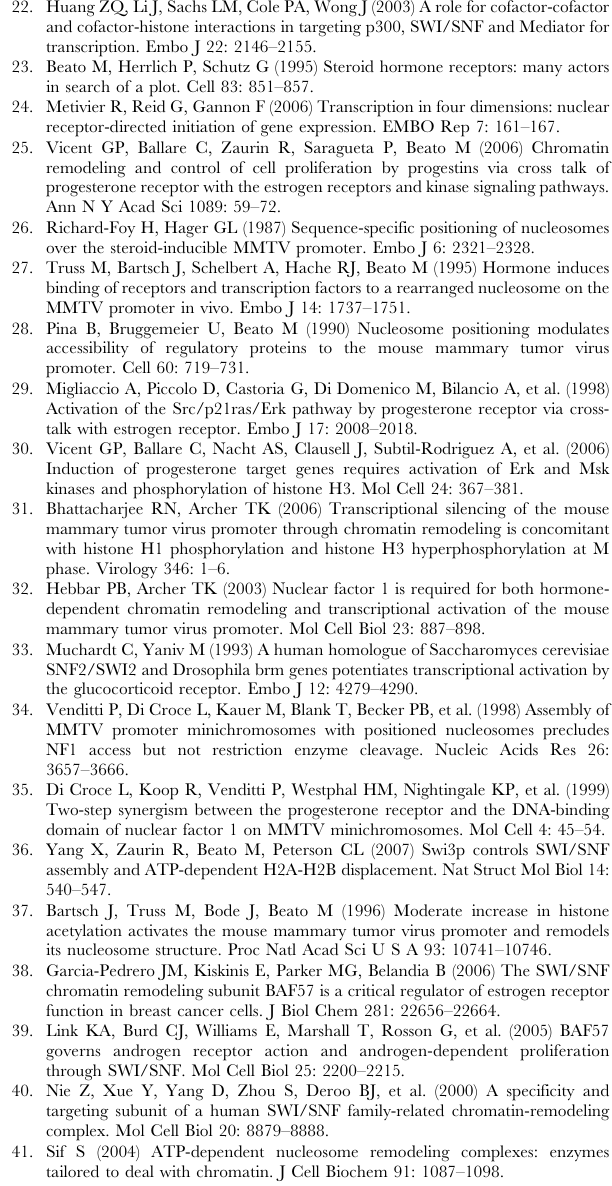
Figure S4 Brg1 and Brm are required for the interaction of BAF and PBAF complexes with the H3K14ac mark. (A) Nuclear extracts derived from T47D-MTVL cells transfected with control and Brg1 and Brm siRNAs were used for pulldown experiments with the indicated H3 tail peptides coupled to beads. Immuno- blotting was performed for the presence of BAF57 and H1. (B) Nuclear extracts derived from T47D-MTVL cells transfected with control and Brg1 and Brm siRNAs were used for immunoprecip- itation either with BAF57 antibody or with normal rabbit IgG as a negative control (IgG). The immunoprecipitates (IP) were analyzed by western blotting with BAF155 and BAF170 specific antibodies.